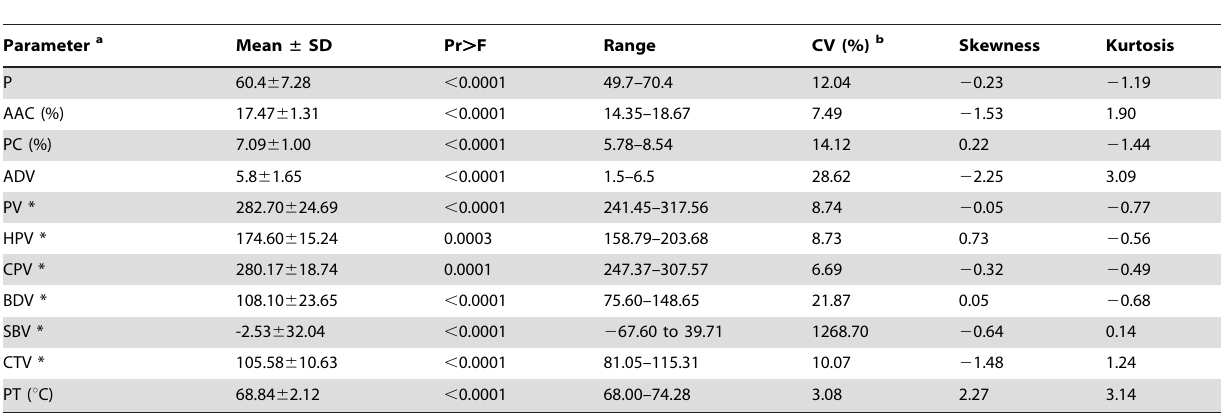
Table 1. Means and ranges of eating quality parameters in eight japonica rice varieties.